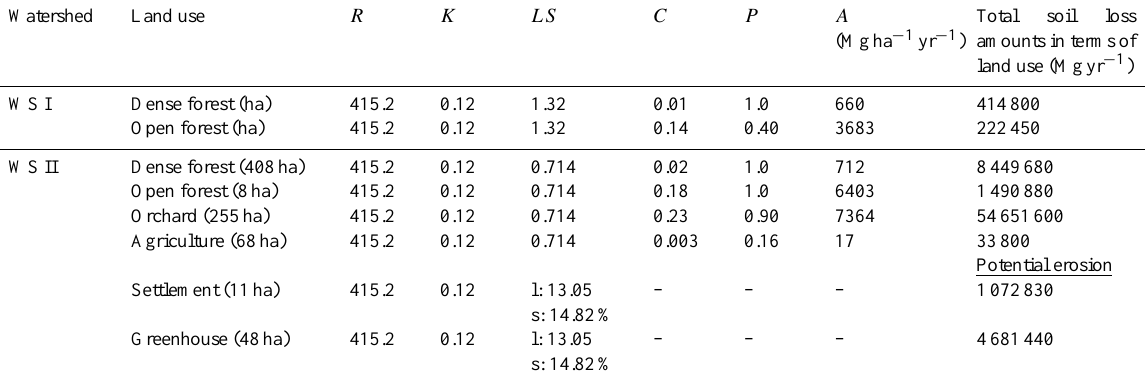
Table 3. Factors affecting the USLE and the amount of soil loss for WS I. Rainfall factor ( R ); soil erodibility factor ( K ); topographic factor ( LS ); cropping management factor ( C ); and erosion control practice factor ( P ). Watershed Land use R K LS